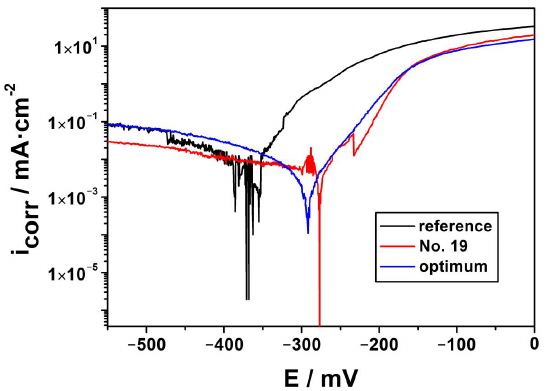
Figure 7. Polarization curves for experiment No. 19 and the predicted one (with levels +1, +1, − 1, and +1) performed experimentally compared to unprotected steel CR4